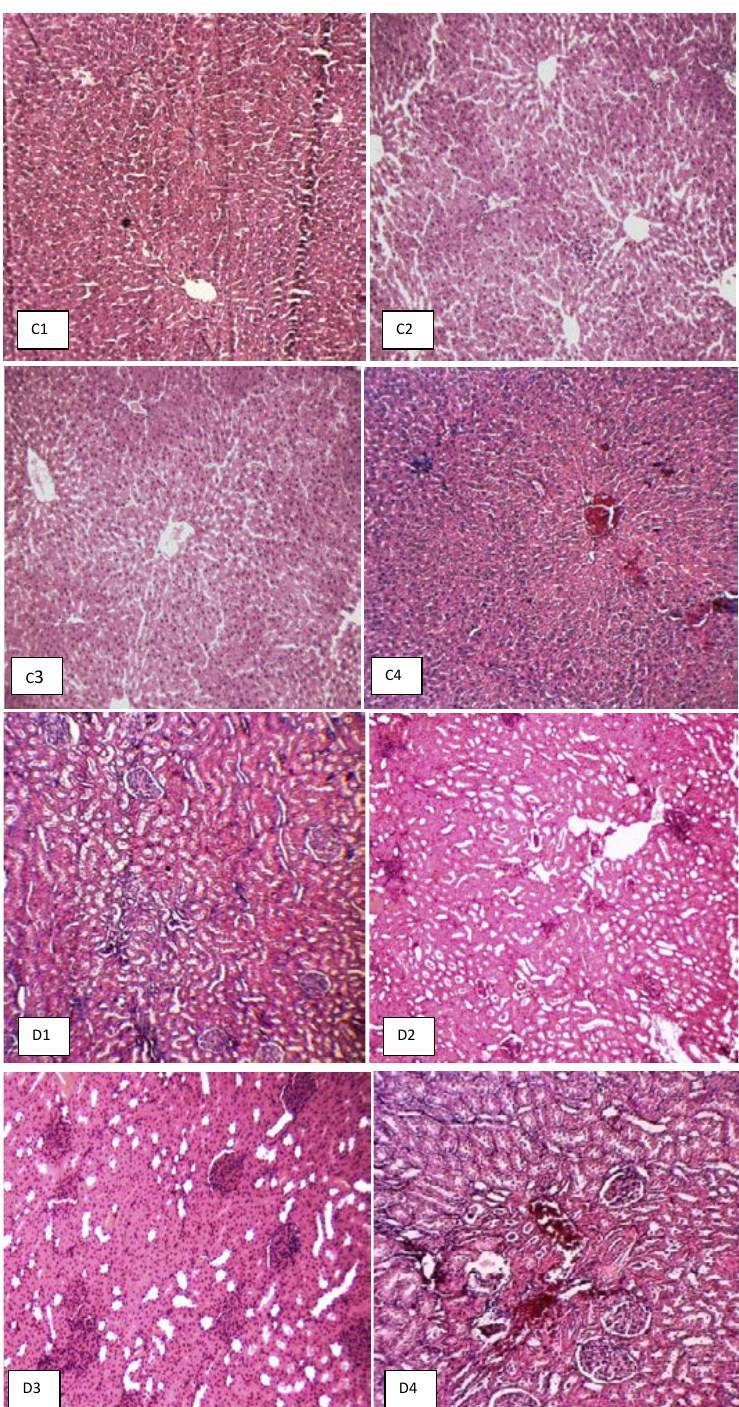
Fig. 2. Photomicrographs of heart, lung, liver and kidney sections obtained from rats exposed to different concentrations of NSPs. (A1, B1, C1, D1) control rats , (A2, B2, C2, D2) rats received 20 mg/kg of NSPs, (A3, B3, C3, D3) rats received 80 mg/kg of NSPs and (A4, B4, C4, D4) rats received 320 mg/kg of NSPs. Panels (A1, A2, A3): normal heart, A4: congestion, myocytolysis and edema in heart. Panels (B1, B2, B3): normal lung, B4: severe alveolar edema, hemorrhage and inflammation in lungs, Panels (C1, C2, C3): normal liver, C4: congestion and inflammation in liver. Panels (D1, D2, D3): normal kidney, D4: congestion and inflammation in kidney. (Staining with hematoxylin and eosin). Magnification: 100 x for panels.